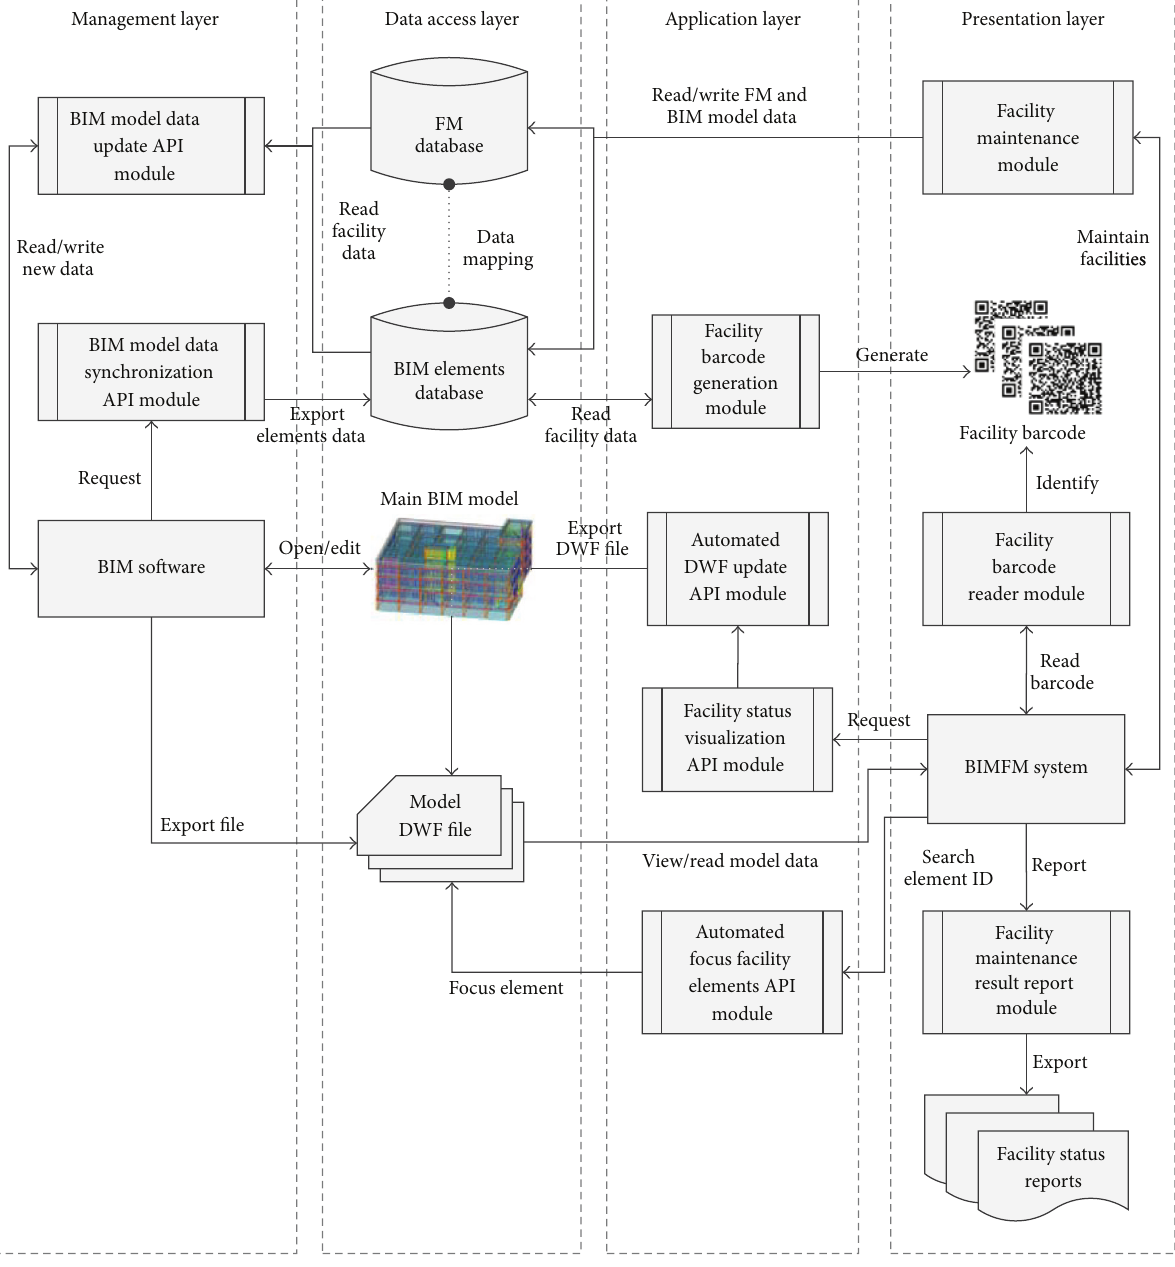
Figure 2: System and module framework of the BIMFM